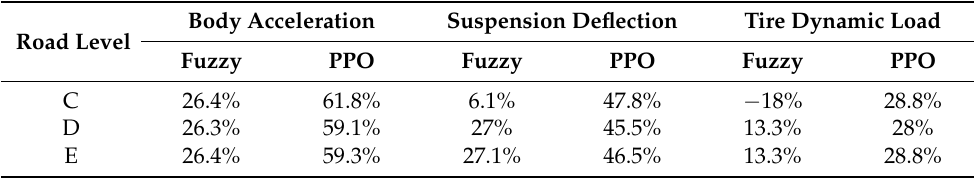
Table 5. The percentages of RMS values of the two semi-active suspensions for a light vehicle under the same